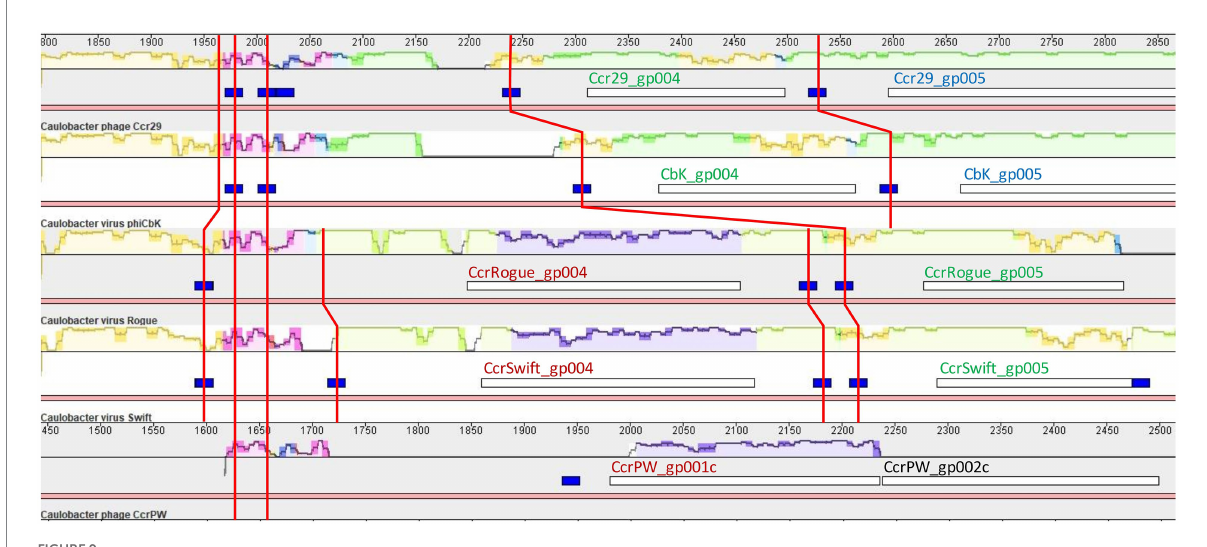
FIGURE 9 Partial view of Mauve alignment of DTRs from Caulobacter Φ Cbk-like phages with significant sequence identity. Sequence conservation is shown using the backbone color scheme, with mauve regions representing areas conserved among all displayed genomes. Open reading frames are shown as white boxes and predicted CtrA-binding sites as blue boxes. Superimposed red lines trace the conserved regions harboring predicted CtrA-binding sites. Colors in the locus tags of open reading frames designate orthologous